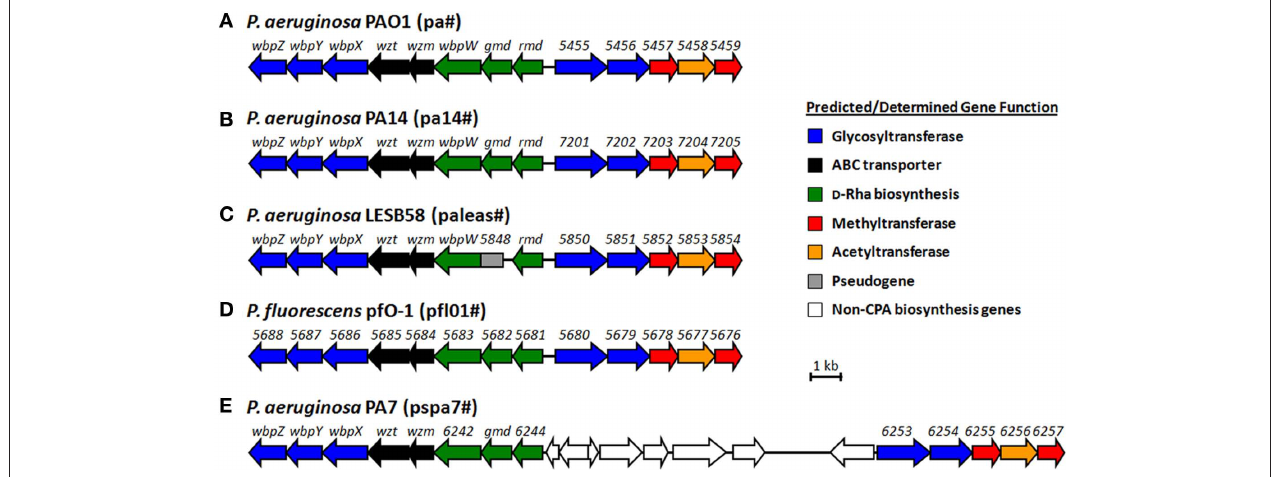
FIgure 3 | Proposed CPA gene clusters of (A) P. aeruginosa PAO1, (B) PA14, (C) LeSB58, (e) PA7, and (D) P. fluorescens pfO-1. The organism-specific identifier for numbered genes of unknown function is indicated in brackets beside